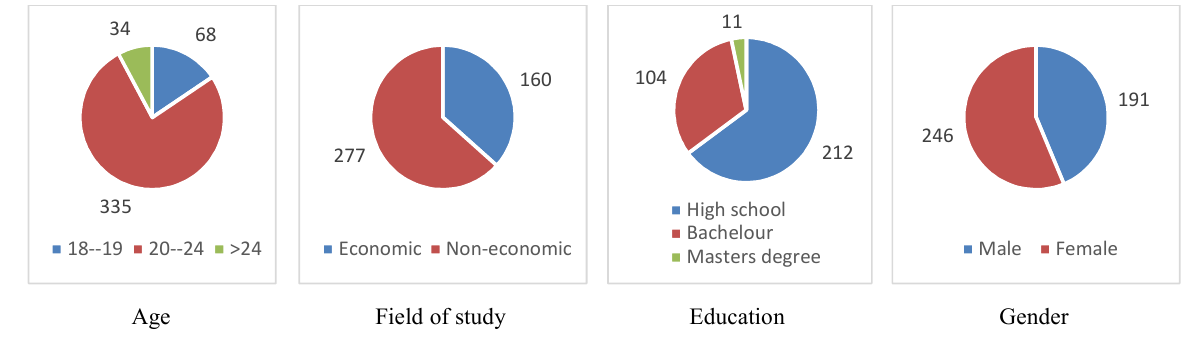
Fig. 2. Personal Characteristics of the participants